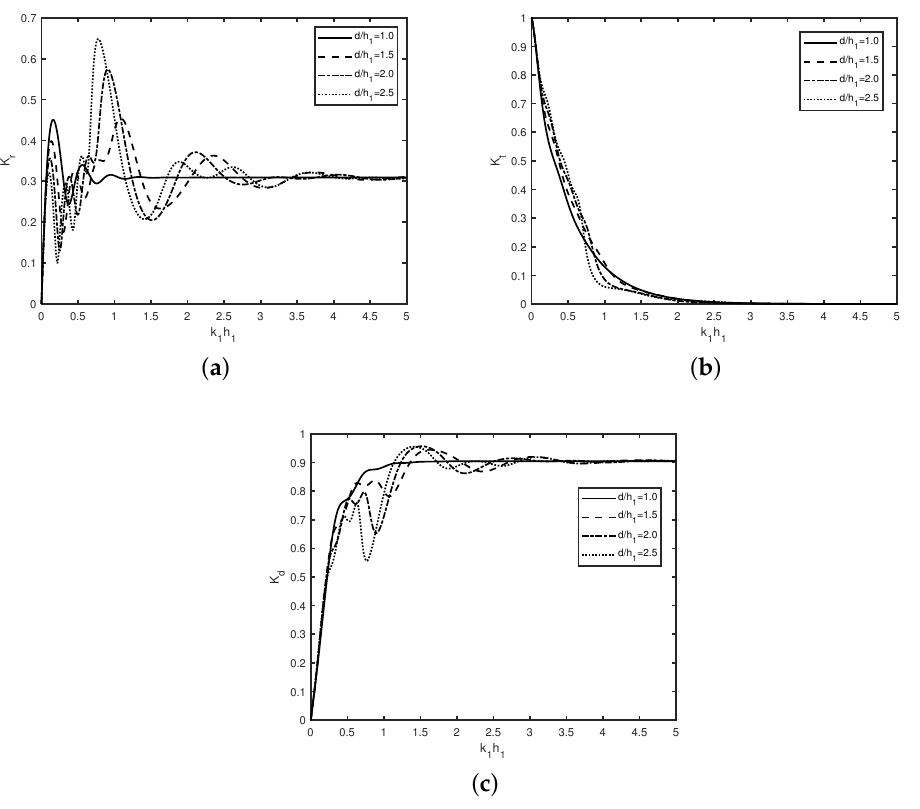
Figure 7. Variation of ( a ) reflection coefficient K r , and ( b ) transmission coefficient K t , ( c ) dissi- pation coefficient K d versus wave number k 1 h 1 for different d / h 1 with C f = 0.5, h 2 / h 1 = 0.25, d / h 1 = 2, θ = 20 ◦ , N = 4, h 1 = 5